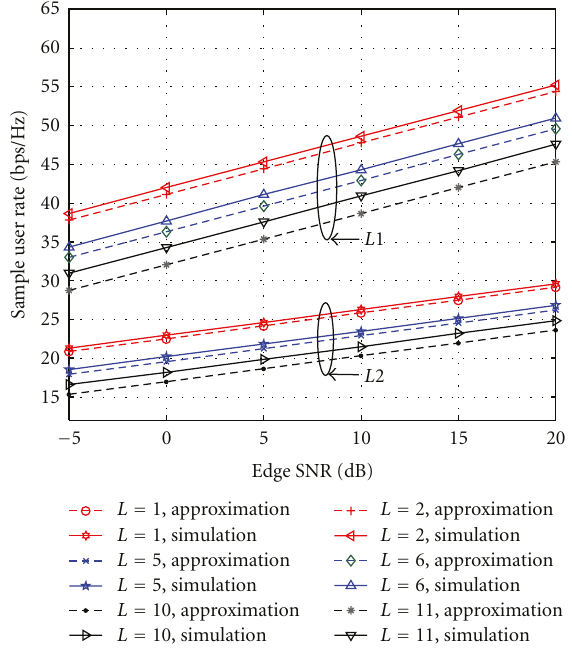
Figure 2: Ergodic rate of a sample user k versus edge SNR for a given realization of user locations, di ff erent values of L , and (cid:4) k = 1,2. The dashed lines indicate the rate obtained from the lower bound approximation, that is, (cid:7) R k ( (cid:4) k , L ), while the solid lines represent the rate obtained from the simulation, that is, R k ( (cid:4) k , L ).